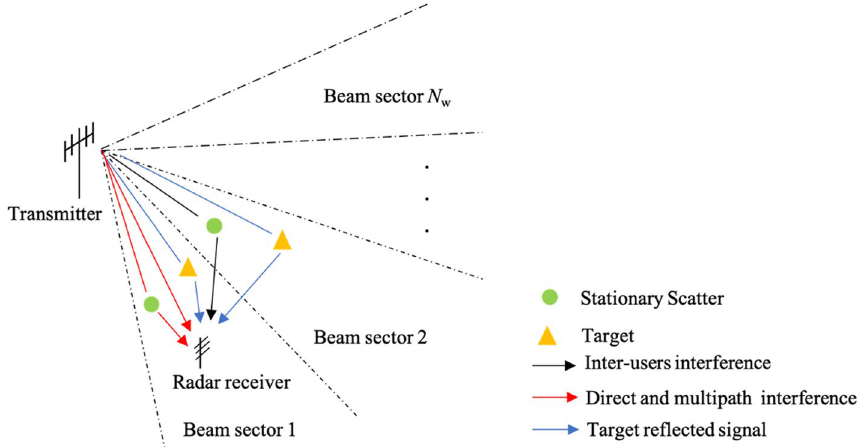
Fig. 1 MU-MIMO-OFDM passive